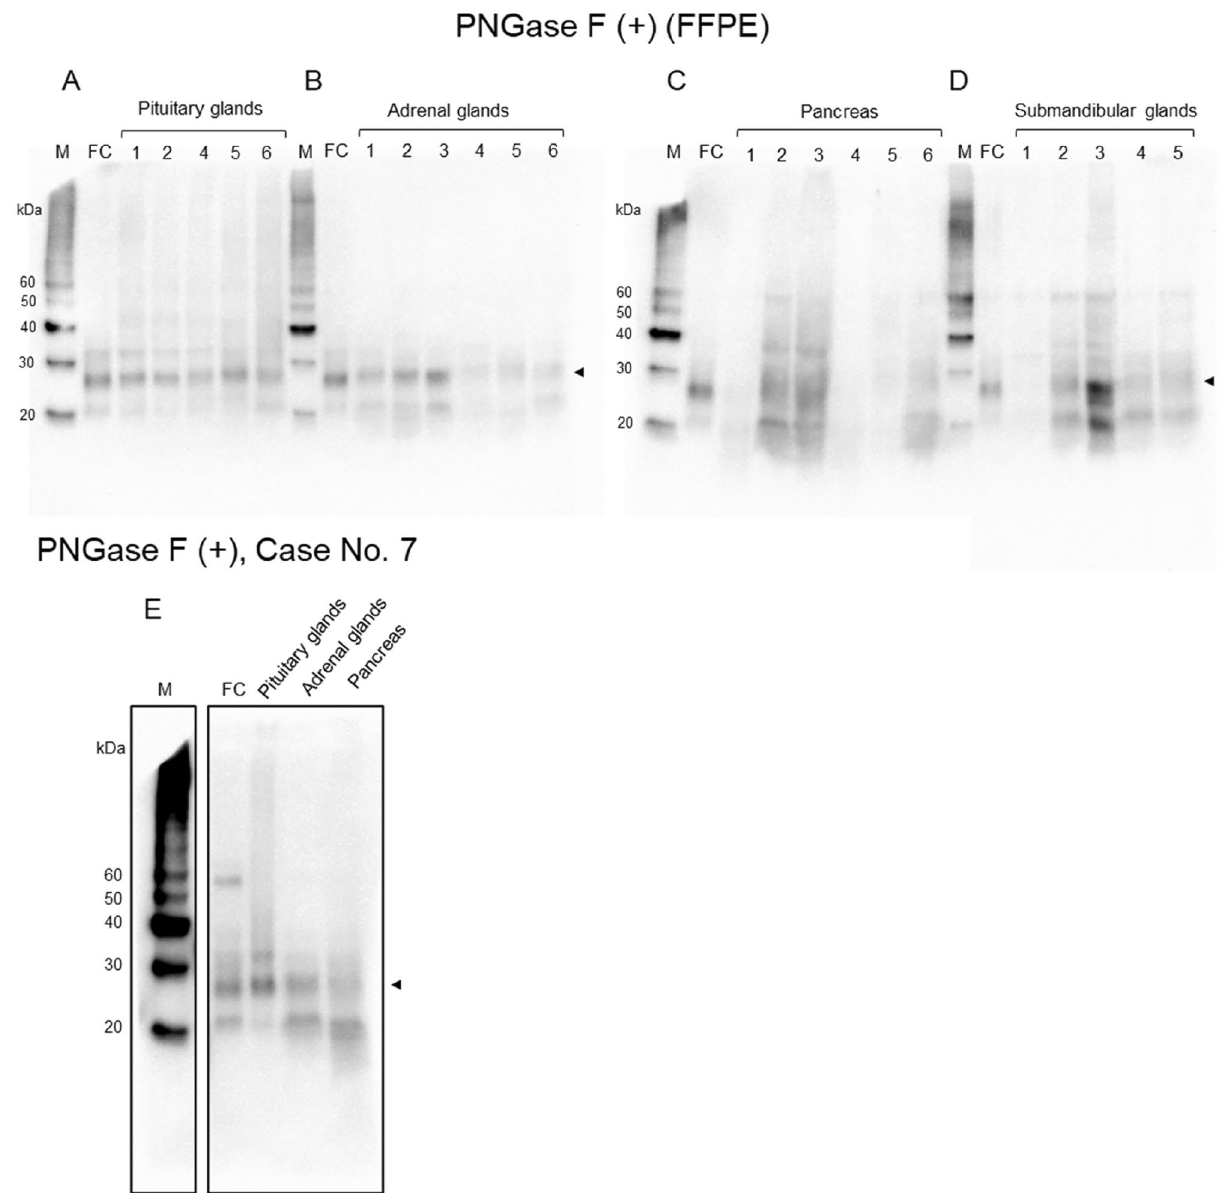
Figure 3. Western blot analyses from FFPE samples after deglycosylated treatment. ( A ) Pituitary glands, ( B ) adrenal glands: PrP signals are mainly observed at the molecular weight of 25 kDa (arrow head), which is correspond to nonglycosylated PrP. ( C ) Pancreas: In the case 2 and 3, PrP signals are mainly observed at the molecular weight of 25 kDa, however in the case 1, 4, 5, and 6, 25 kDa signals were not evident. ( D ) Submandibular glands: PrP signals are mainly observed at the molecular weight of 25 kDa (arrow head). However, in the case 1, PrP signals were not evident. ( E ) Case 7: In the frontal cortex, pituitary gland, adrenal gland and pancreas, PrP signals are mainly observed at the molecular weight of 25 kDa (arrow head), which is correspond to nonglycosylated